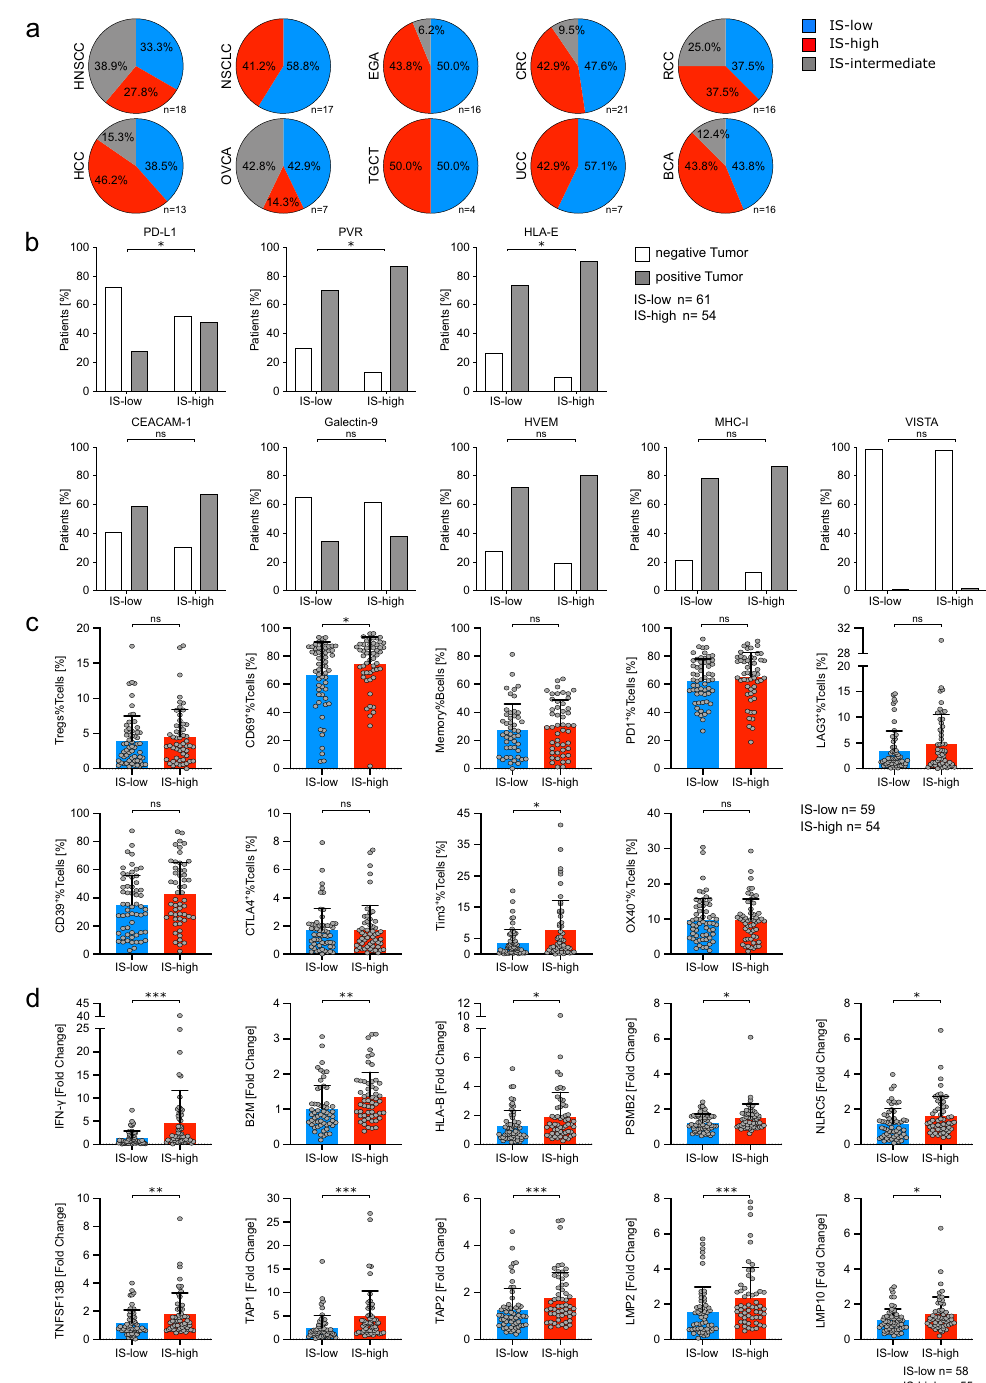
Fig. 5 Immune-score high patients show increased antigen presentation. a Distribution of immune-score low (IS-low), high (IS-high) and intermediate patients for different cancer types. b Tissue-micro array (TMA) immunohistochemistry was performed to determine immune- escape factor occurrence on tumor cells. Percentage of immune-score high/low patients, positive or negative for the respective immune- escape factors are shown. c Flow cytometry was performed to determine immune-subset in fi ltration and immune-regulatory molecule expression on tumor-in fi ltrating T cells. Percentages of CD4 + CD25 high FoxP3 + regulatory T cells (Tregs%Tcells), CD69 + activated T cells (CD69 + %Tcells), IgD - CD27 + CD19 + CD20 + memory B cells (Memory%Bcells) and the percentage of immune-regulatory molecule expression (PD1, LAG3, CD39, CTLA4, Tim 3 and OX40 in percent of T cells) were strati fi ed according to immune-score low/ high. d NanoString RNA expression analysis of tumor and matched normal tissue was performed to determine relative changes for each patient. Bar charts show fold changes in expression in immune-score high/ low patients for the indicated genes. Signi fi cant differences calculated with two-sided Fisher ’ s exact test ( b ), two-tailed unpaired Mann-Whitney test ( c and d ) are indicated by asterisks. * p ≤ 0.05, ** p ≤ 0.01, *** p ≤ 0.001, **** p ≤ 0.0001. When appropriate, mean ± SD is